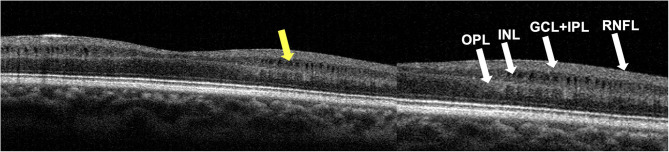
Foveal OCT scan from subject A8's right eye. Segmentation identifies macular microcysts of inner nuclear layer (INL) as pointed by the yellow arrow. Retinal nerve fiber layer (RNFL), ganglion cell layer (GCL), inner plexiform layer (IPL) and outer plexiform layer (OPL) are shown on the right panel.